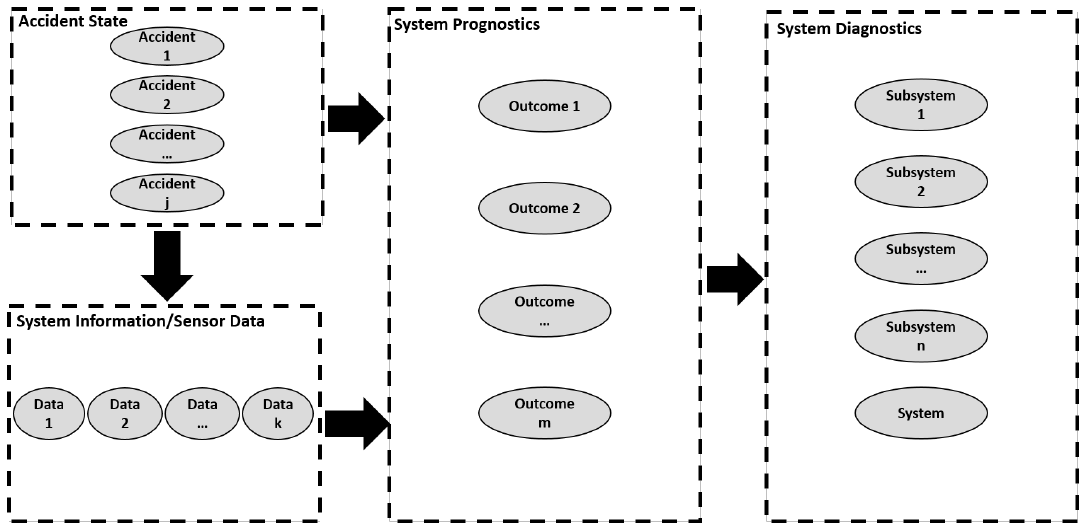
Figure 4. The nodes within a DBN model designed to monitor CES health following an accident event can be classified into four information regions: accident state, system information and sensor data, system prognostics, and system diagnostics. The arrows drawn between the information regions reflect the directed relationships; the model is designed so that each node is fully connected to the child information region (i.e., each “Accident State” node is fully connected to every “System Information/Sensor Data” node and every “System Prognostics”